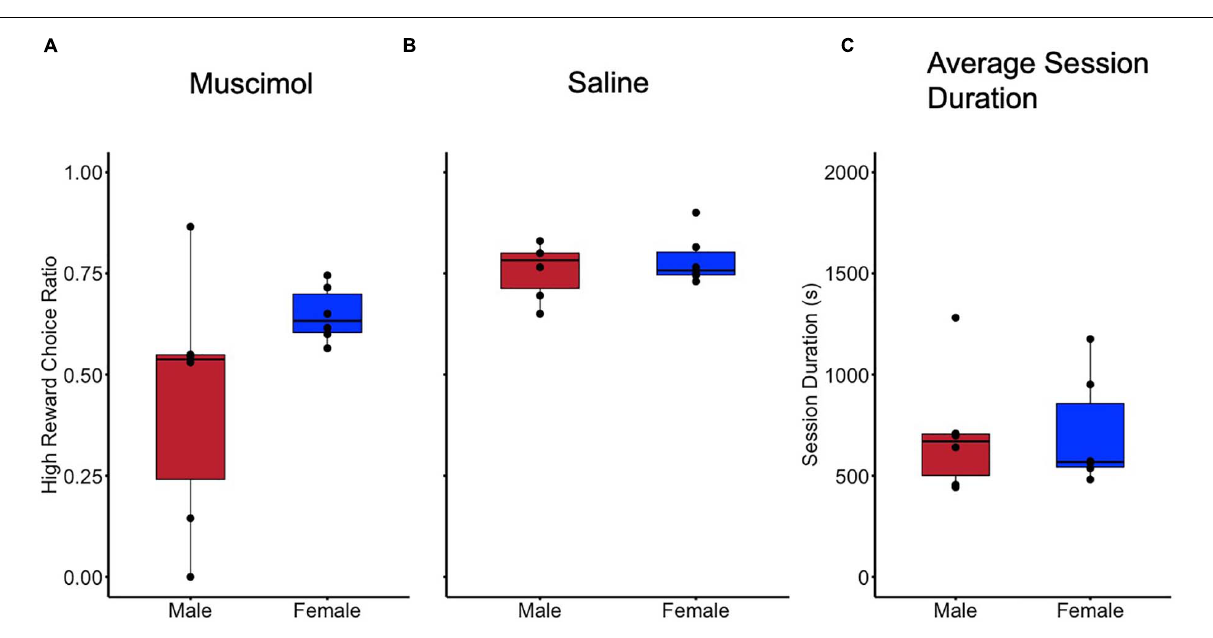
FIGURE 4 | No difference in behavior was observed in reward preferences when considering sex as a biological variable. (A) Preference for high reward compared during inactivation (Muscimol) sessions compared by sex. (B) Preference for high reward compared for sex during control (Saline) sessions. (C) Session duration in seconds for all sessions compared between